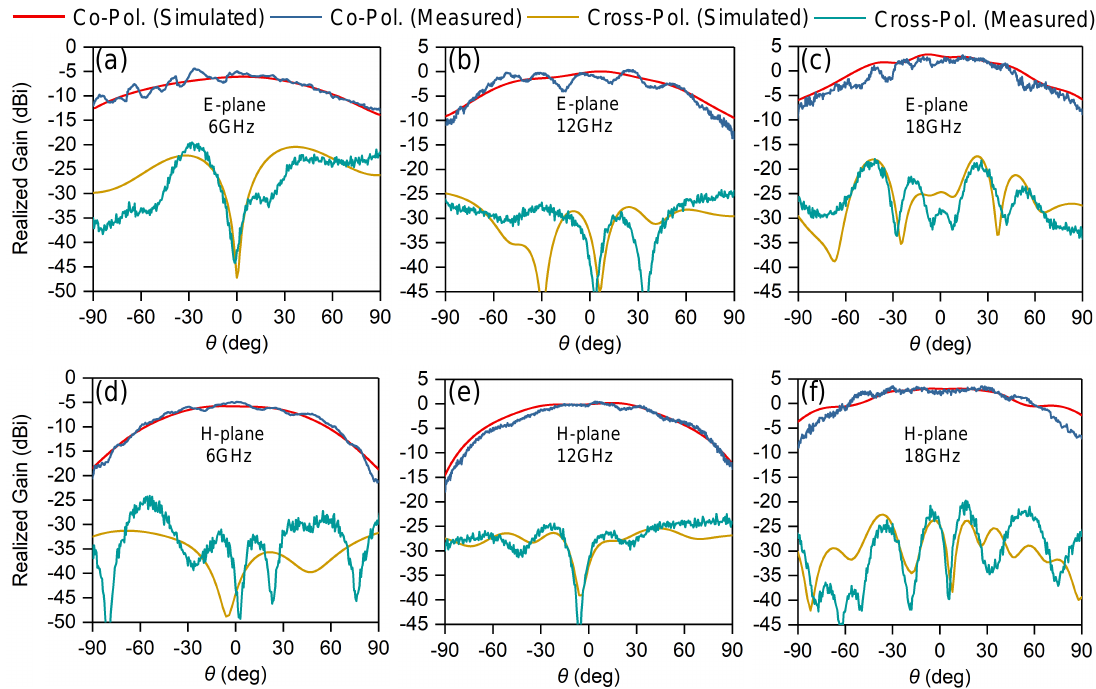
Figure 15. Comparisons of measured and simulated embedded element patterns for the central element (8, 8) of the proposed array. ( a ) E-plane @ 6 GHz; ( b ) E-plane @ 12 GHz; ( c ) E-plane @ 18 GHz;